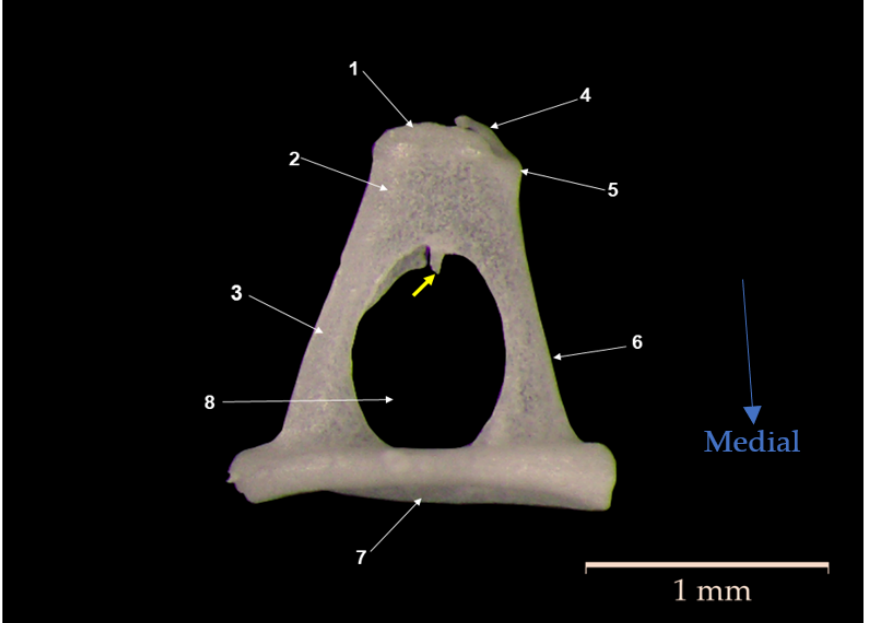
Figure 4. Histological aspects of the incus. Arrows indicate areas selected for histology. A—marrow cavity filled with adipocytes; B—compact bone; C—articular hyaline cartilage; black star—incu ‐ domalleolar ligament; MC—mineralized cartilage with posterior incudal ligament (red star).